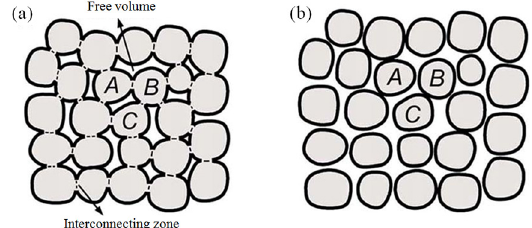
, the clusters are connected to each Figure 13. (a) When T< T g other by interconnecting zone; (b) When T> T , the clusters are g separated by free volume. 127 In addition, Figure 14 shows a schematic illustration to further understand vividly the mutual relation among the three parts of the model proposed by Fan. The black-color parts represent the clusters, and the interconnecting zone between the clusters and the free volume region are shown in Figure 14 (b), and Figure 14 (c), respectively. The blue area in Figure 14 (b) represents the interconnecting zone between clusters, which may contain several layers of atoms. The atomic configuration in this interconnecting region is looser as compared with the cluster zones. The atoms marked with half blue and half red in Figure 14 (d) show the connecting state between atoms just near the clusters. The blue parts correspond to interconnection zones, while the red parts connect with the region belonging to free volume.